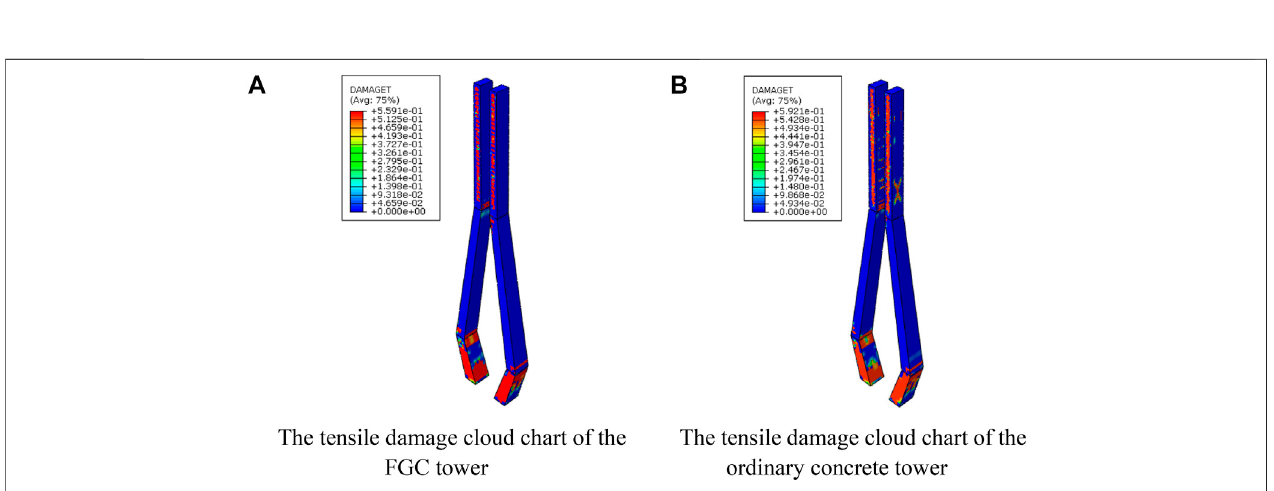
FIGURE 18 | The tensile damage cloud chart. (A) The tensile damage cloud chart of the FGC tower. (B) The tensile damage cloud chart of the ordinary concrete tower.